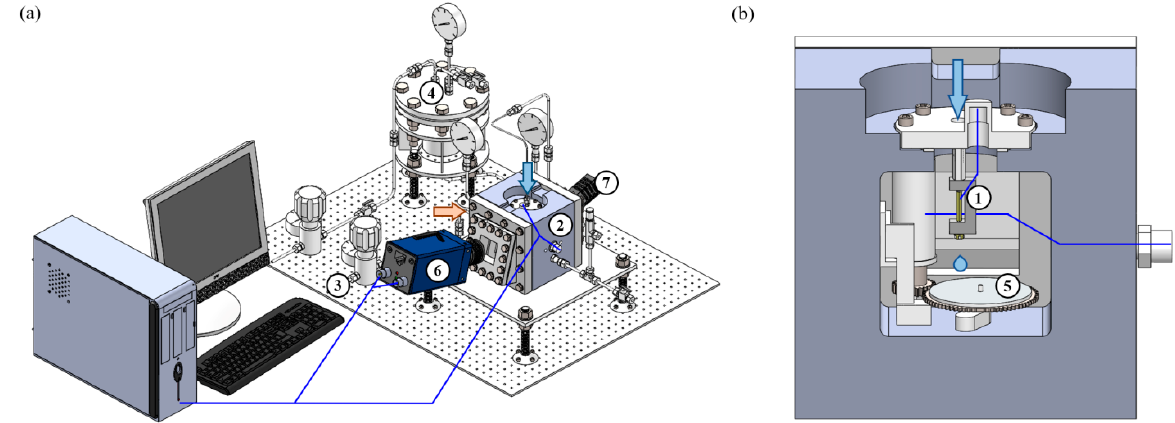
Figure 1. ( a ) Schematic diagram of the experimental setup for the droplet impact at elevated ambient pressures and ( b ) sectional view of the pressure vessel where the experimental equipment or pipeline corresponded to the serial number. (1) Droplet generator, (2) constant volume chamber, (3) regulating valve, (4) liquid tank, (5) solid surface, (6) high-speed camera, and (7) LED lamp. In ( a ), the orange arrow represents the injection of high-pressure compressed nitrogen into the chamber and the blue arrow represents the liquid supply into droplet generator respectively. The blue solid line represents the path for electrical signals and